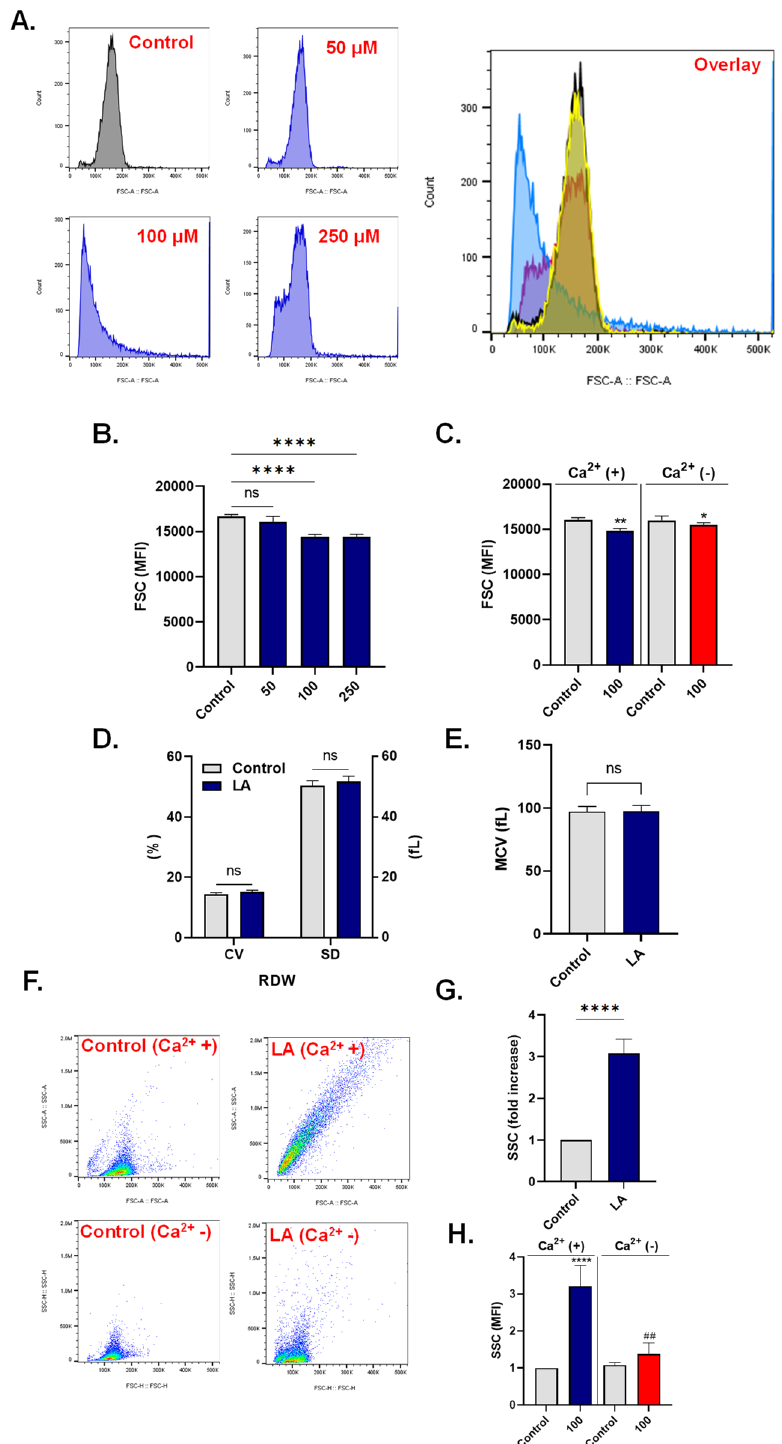
Figure 4. LA causes loss of cellular volume and increased granularity. ( A ) Representative histograms of FSC of cells exposed to 0–250 µ M of LA. ( B ) LA-induced decrease in MFI of FSC. ( C ) LA-induced decrease in FSC MFI with and without Ca 2+ . ( D ) RDW expressed in terms of coefficient of variation (CV) and standard deviation (SD). ( E ) MCV. ( F ) Dot plot scattergrams of SSC and FSC of control and LA-treated cells in the presence and absence of Ca 2+ . ( G ) Fold increase in SSC. ( H ) Fold increase in SSC in the presence and absence of Ca 2+ . ns indicates not significant, * ( p < 0.05), ** ( p < 0.01), and ****( p < 0.0001) indicate significantly different values from control conditions whereas ## ( p < 0.01) indicates statistical significance compared to LA-treated cells.